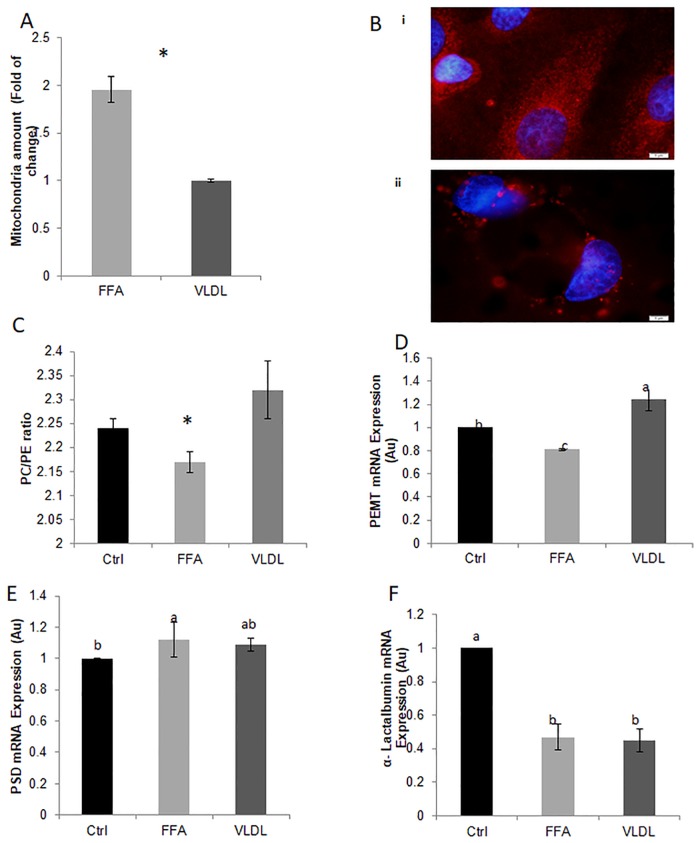
Long chain fatty acid macrostructure in culture medium alters mitochondrial quantity and gene expression of enzymes involved in the PL synthesis pathways in MEC.(A) Mitochondria was quantified by monitoring the fluorescence intensity of Mitotracker deep red staining and presented as fold change compared to the control. (B) Representative images of mitochondria amount in MEC treated with (i)FFA and (ii) VLDL. Scale bars, 5 μm n = 4 for each replicate in each treatment, total of 2 replicates (C) Ratio of phosphatidylcholine to phosphatidylethanolamine (PC/PE) determined by HPLC-ELSD (D) Phosphatidylethanolamine N-methyltransferase (PEMT) mRNA expression (AU) (E) Phosphatidylserine decarboxylase (PSD) mRNA expression (AU). (F) α-Lactalbumin mRNA expression (AU) n = 4 for each replicate in each treatment, total of 2 replicates.